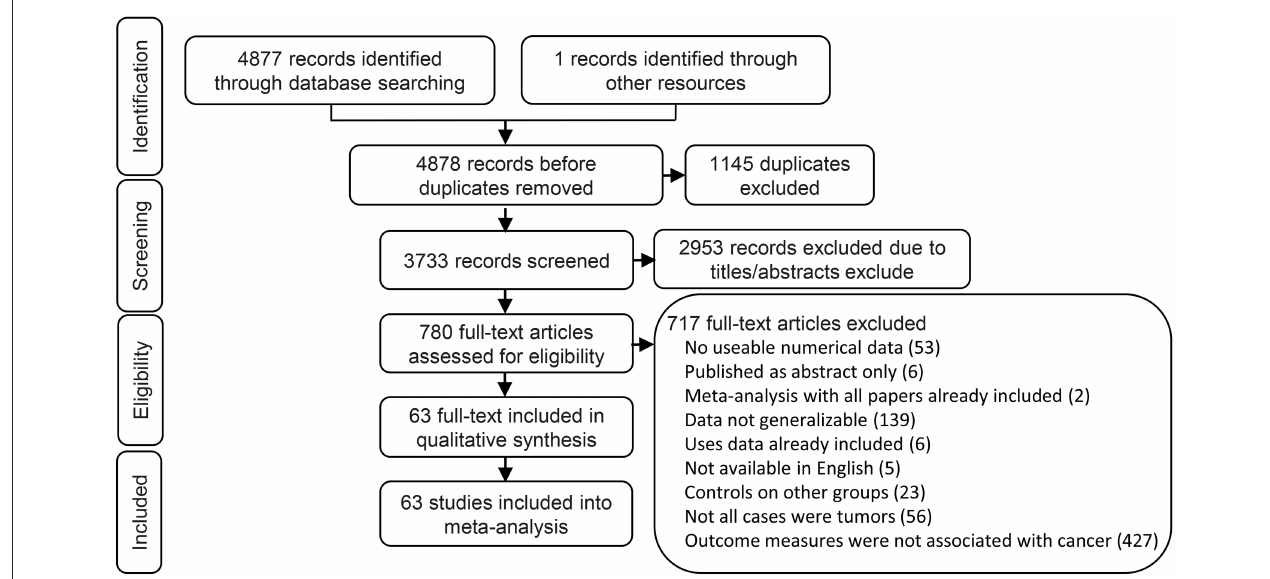
FIGURE 1 | Flow chart of the identification process for eligible